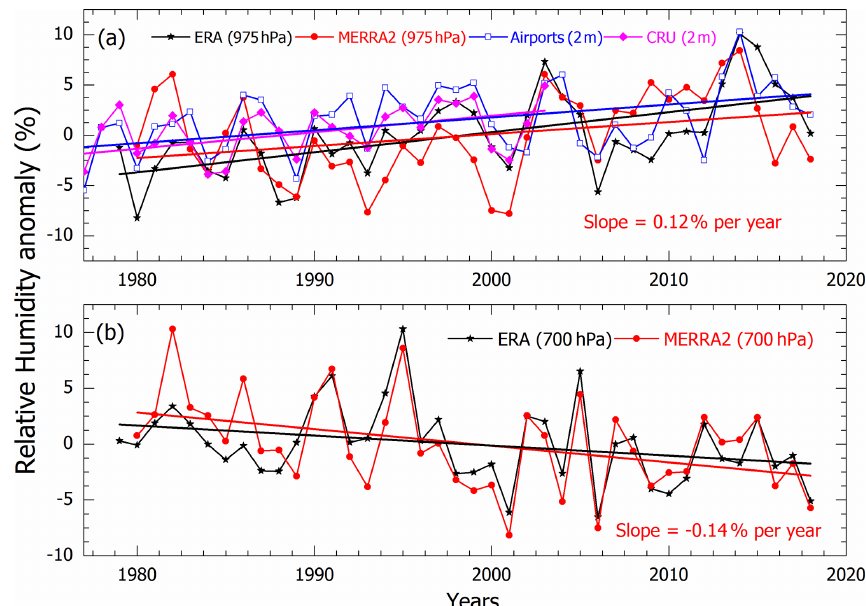
Figure 7. (a) Relative humidity in the boundary layer (975hPa) from reanalysis (interim ECMWF Re-Analysis, ERA-Interim; Modern-Era Retrospective Analysis for Research and Applications, MERRA2; and Climatic Research Unit, CRU) and in situ observations. (b) Relative humidity in the free troposphere (700hPa) taken from reanalysis data.